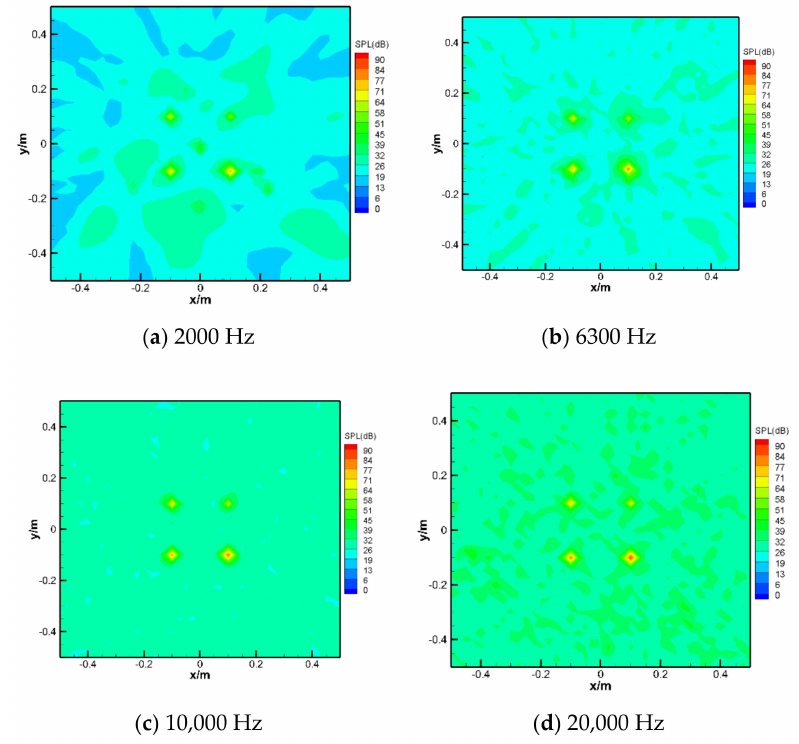
Figure 5. Sound source distribution for subcase B at different frequencies.